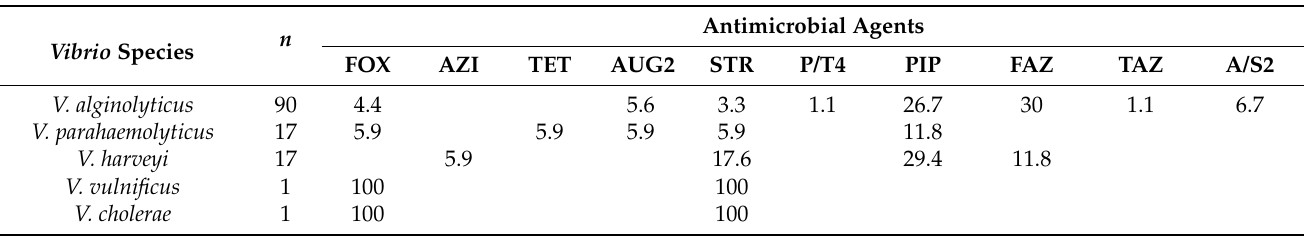
Table 3. Intermediate profile to single antimicrobial agents in percentage. The antimicrobial agents for which no intermediate resistance was found are not shown.